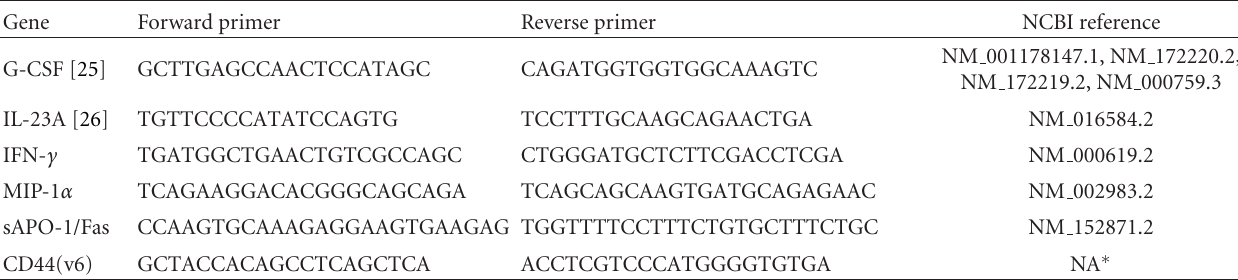
Table 1: List of primers used for real-time PCR